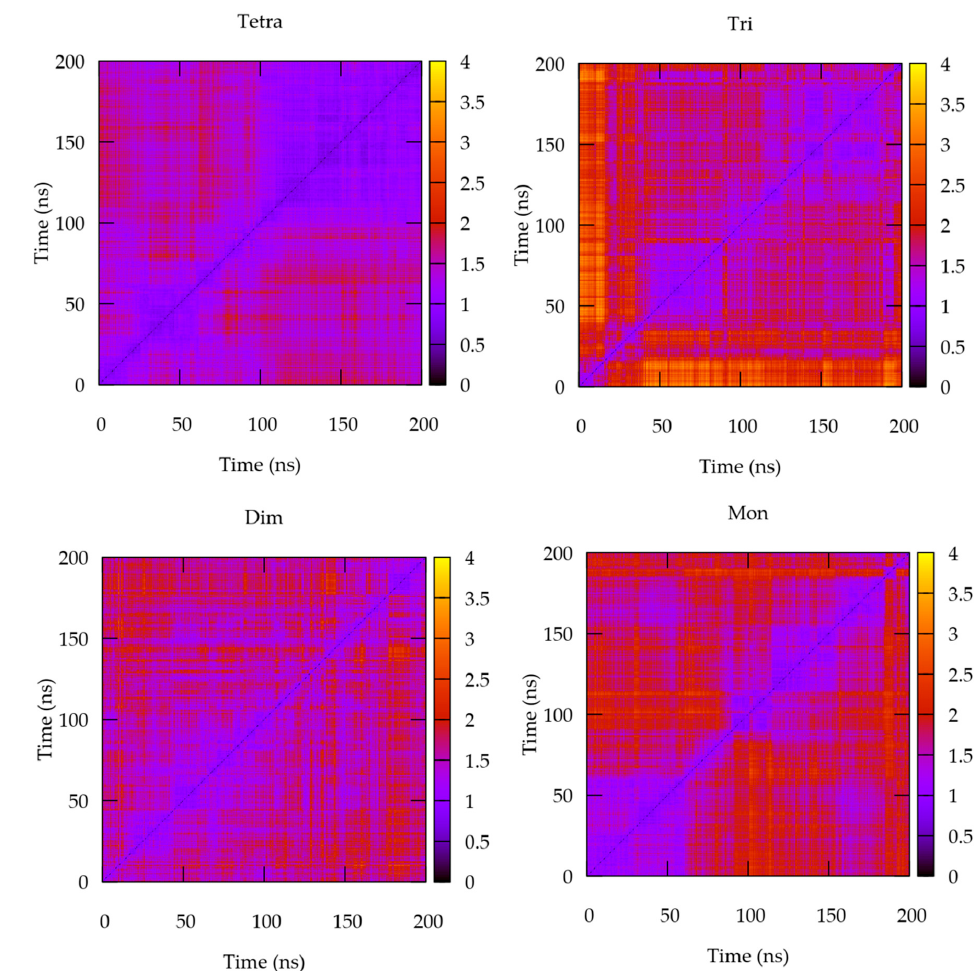
Figure 2. Matrices of all possible RMSD pairs computed from the trajectories of the four species considered (from the left to the right and from the top: tetramer; trimer; dimer and monomer) over the whole 200 ns of the simulations.